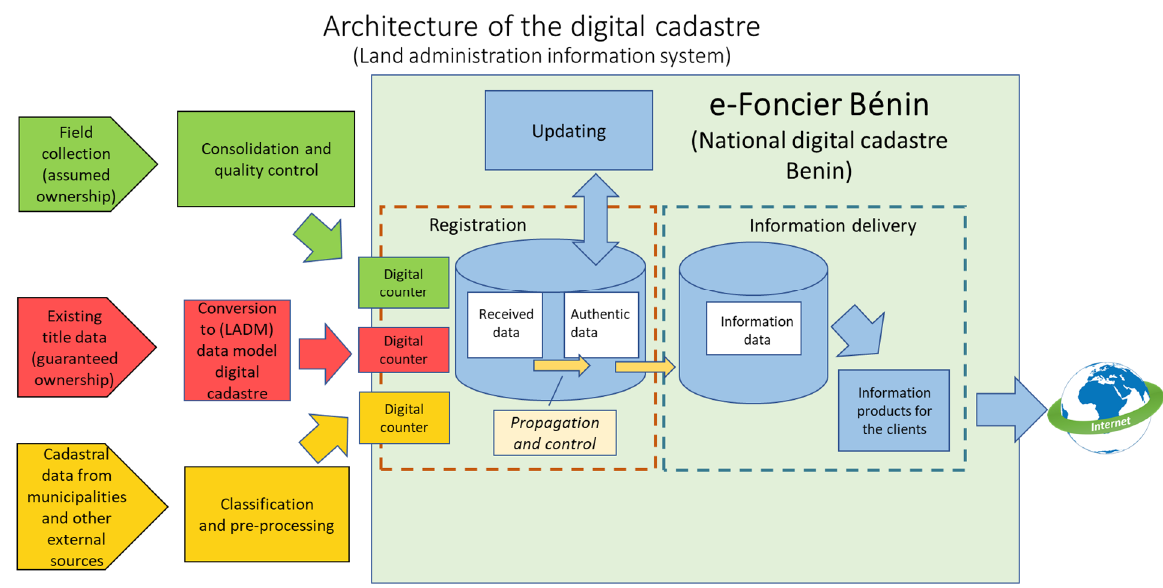
Figure 3. Architecture of the digital cadaster.